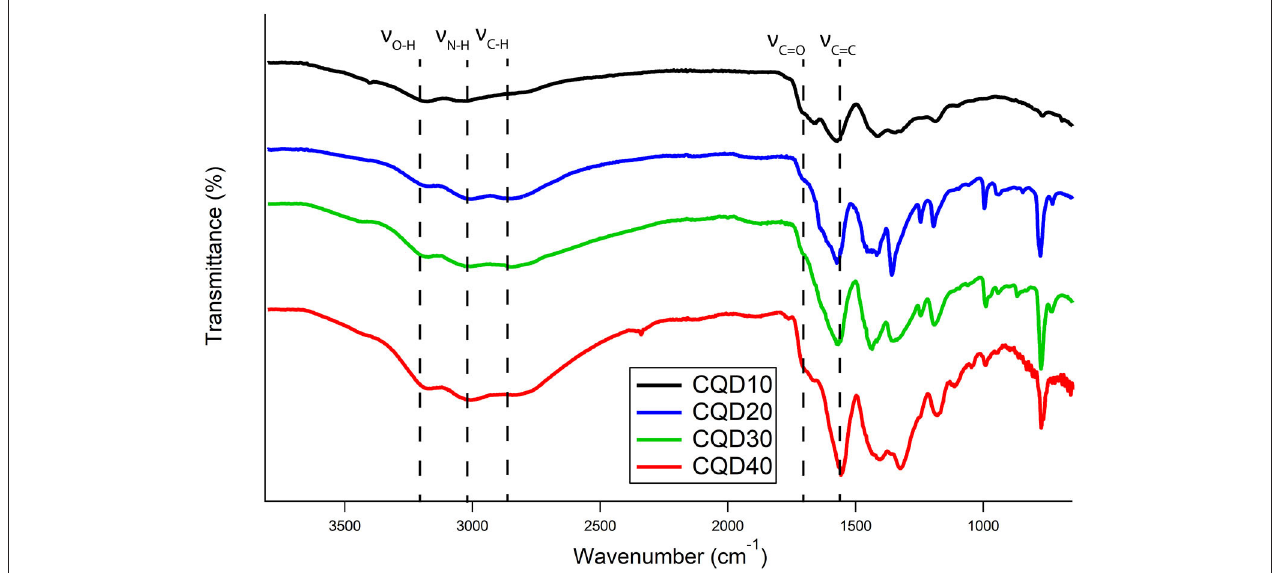
FIGURE 2 | FTIR spectra of CQD10 (black), CQD20 (blue), CQD30 (green), and CQD40 (red).